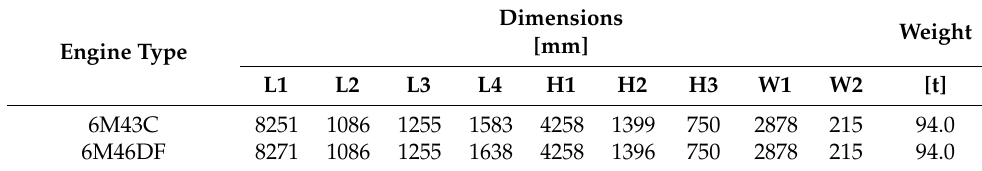
Table 2. The primary dimension of both